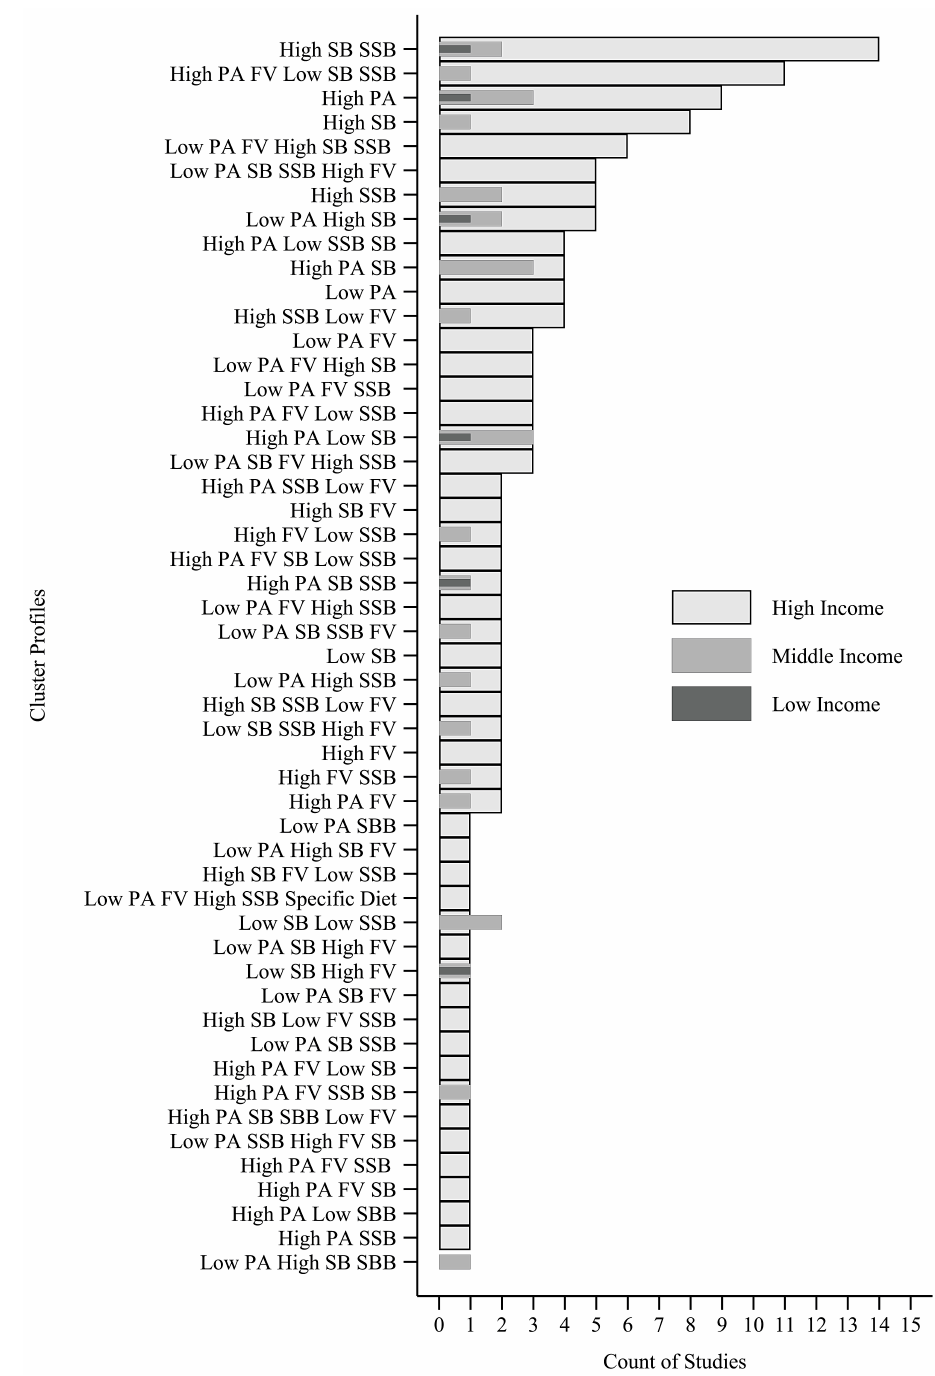
Figure 4. Characteristics of clustering patterns of obesogenic behaviors applying cluster analysis (latent class analysis, latent profile analysis, two-step and K-means) across studies. Middle income includes lower-middle- and upper-middle-income countries. F&V: fruits and vegetables; SSB: sugar- sweetened beverages; SB: sedentary behavior; PA: physical activity. Country income classified by The World Bank (https://datahelpdesk.worldbank.org/, accessed at 7 July 2021) according to year of data collected of each